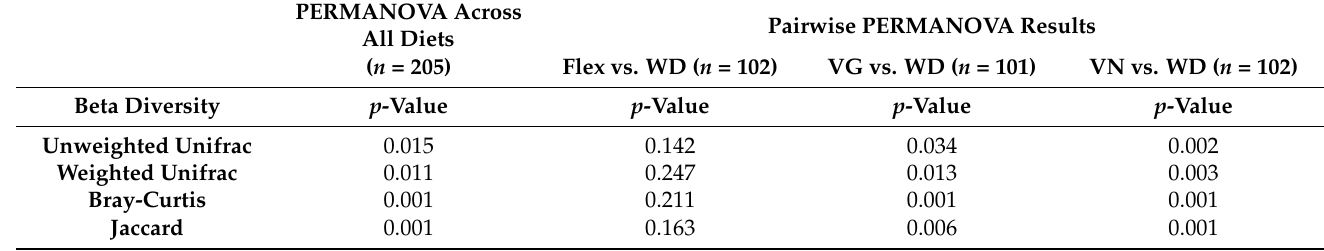
pairwise comparison against WD/reference